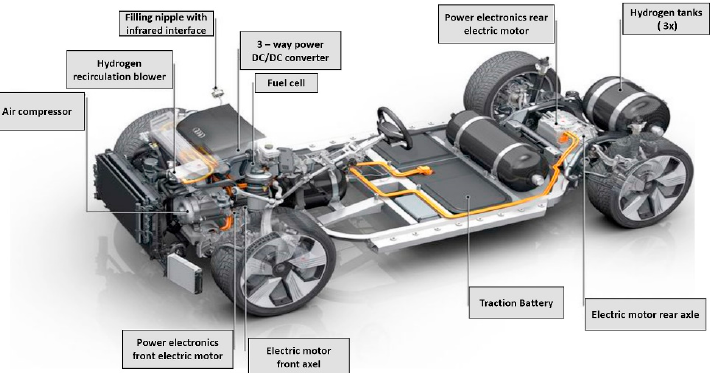
Figure 4. Audi modelled fuel cell electric car [27]. Republished with permission from Elsevier (License no: 5416381285587).